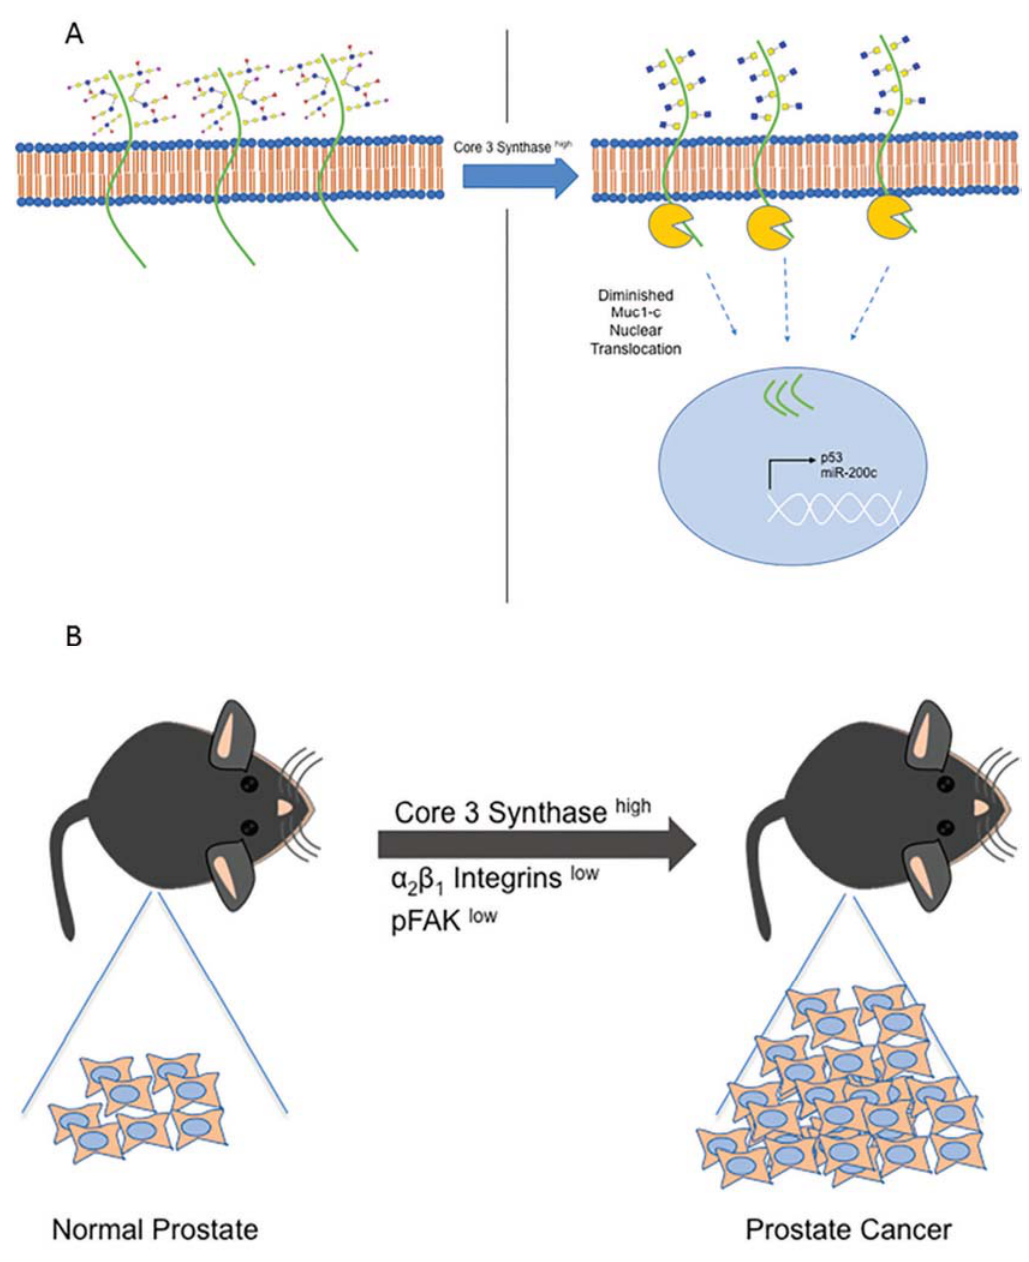
Figure 3. The schema here show the role of Core-3 synthase in the regulation of biological processes in colon cancer ( A ) and prostate cancer ( B ). Core-3 synthase (B3GNT6) negatively regulated the role of MUC-1 in colon cancer. An increase in B3GNT6 reduced MUC-1 C-terminus translocation to nucleus, and increased p53 and miR-200c expression. This phenomenon was observed in an in vitro model of colon cancer. Meanwhile, in prostate cancer, an in vivo study exhibited role of increased Core-3 synthase. To this end, Core-3 synthase overexpressing cells were orthotopically implanted into the prostate of mice and were shown to reduce the tumor burden, along with the expression of α 2 β 1 integrin and pFAK.